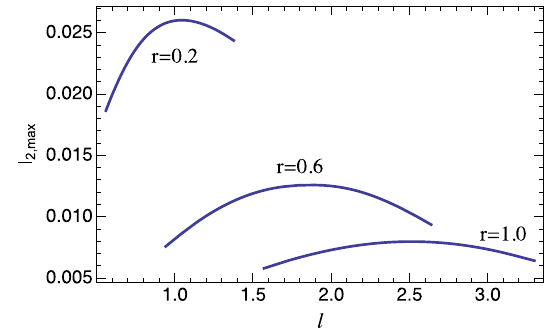
as a function of ; max